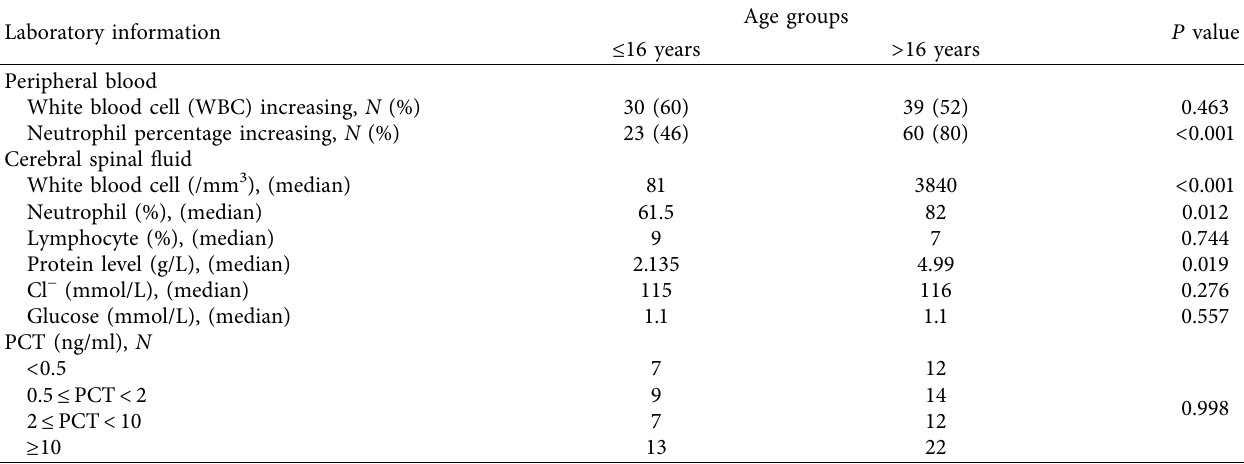
Table 2: Comparison of laboratory analysis of blood and CSF between pediatric and adult IPD cases in Ningxia Hui autonomous region, China, 2013–2021.